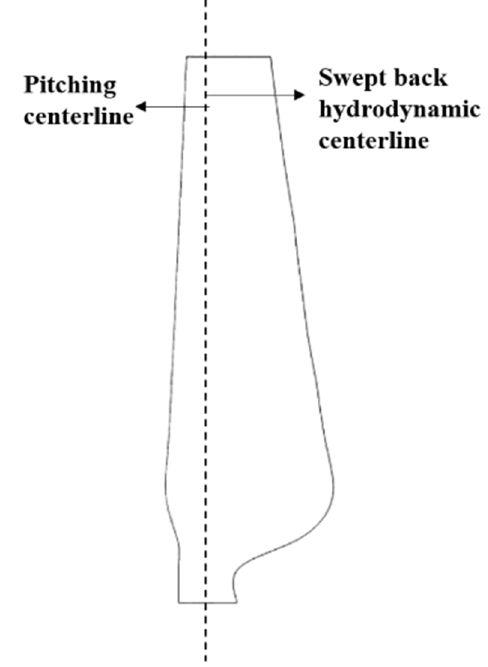
Figure 1. The structure of the initial blade. Table 1. Initial blade design geometric parameters.